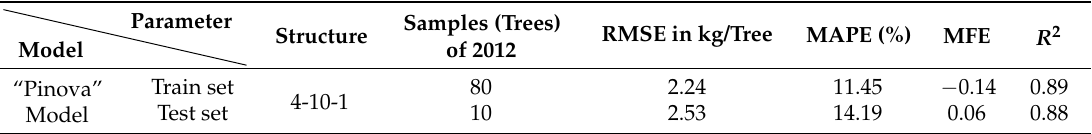
Table 7. The model structure and the evaluation of model performance which was developed based on samples of 2012 for cv. “Pinova”.